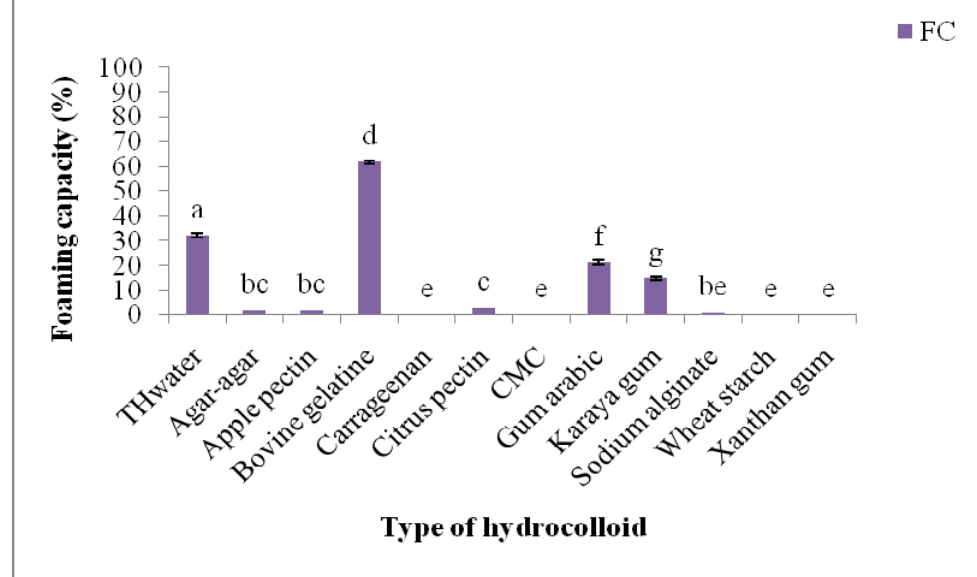
Figure 3. Foaming capacity (FC) of tamarillo and commercial hydrocolloids at time, t = 0.